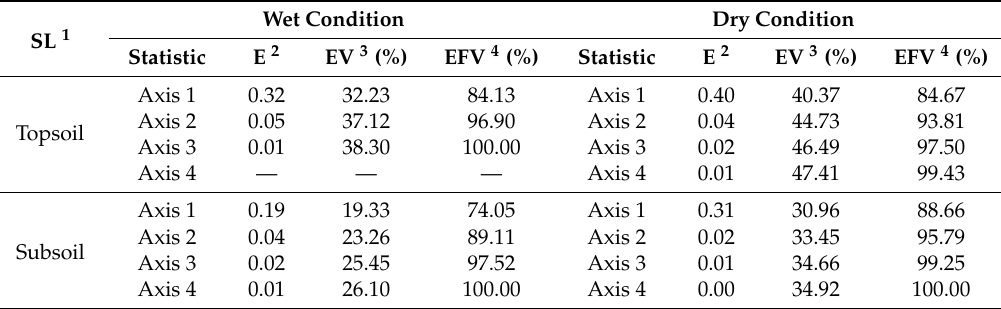
Table 4. Characteristics of the first four axes from the RDA analysis.